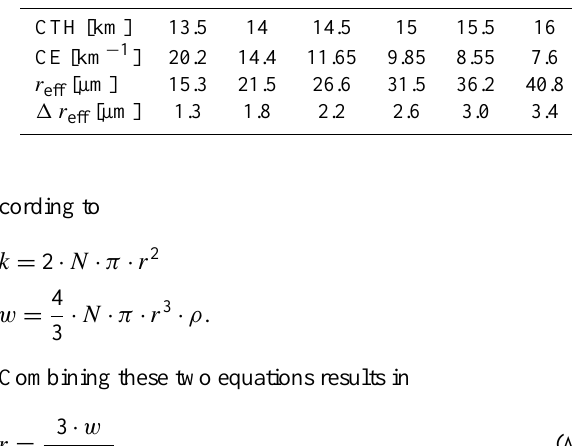
Figure A2. Colour-coded difference between the measured and the modelled O 4 SCD for the simulated range of CTHs and cloud ex- tinctions. The minima describe a curve from 13.4 to 16.7km and from 25 to 7km − 1